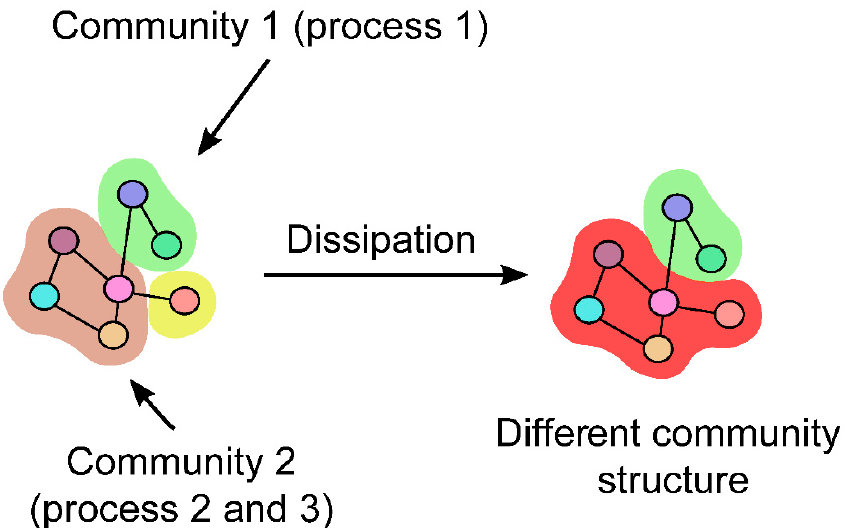
Figure 4. Community dissipation. Community dissipation corresponds to the measurement of how different a given community is across a pair of time points. For example, here, the brown ( left ) community becomes part of the red community ( right ), where the yellow community with a single node ( left ) disappears and becomes part of the red community ( right ).